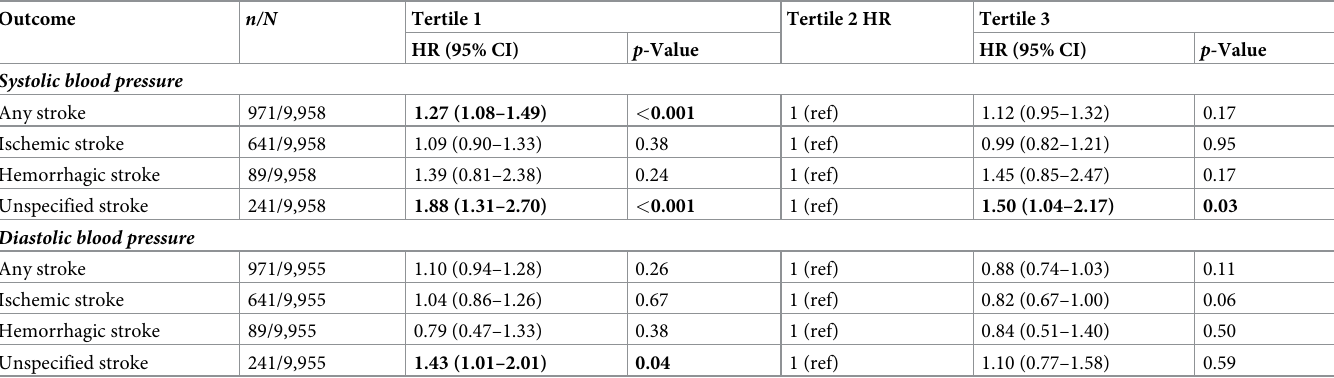
Table 4. Association between rise and fall of blood pressure and incident stroke, ischemic stroke, hemorrhagic stroke, and unspecified stroke AU : InTable 4 : Ieditedthecolumnheadsandmovedthetertiledefinitionstothetablelegend ; asinTable 2 : Pleasecheckforcorrectness : .